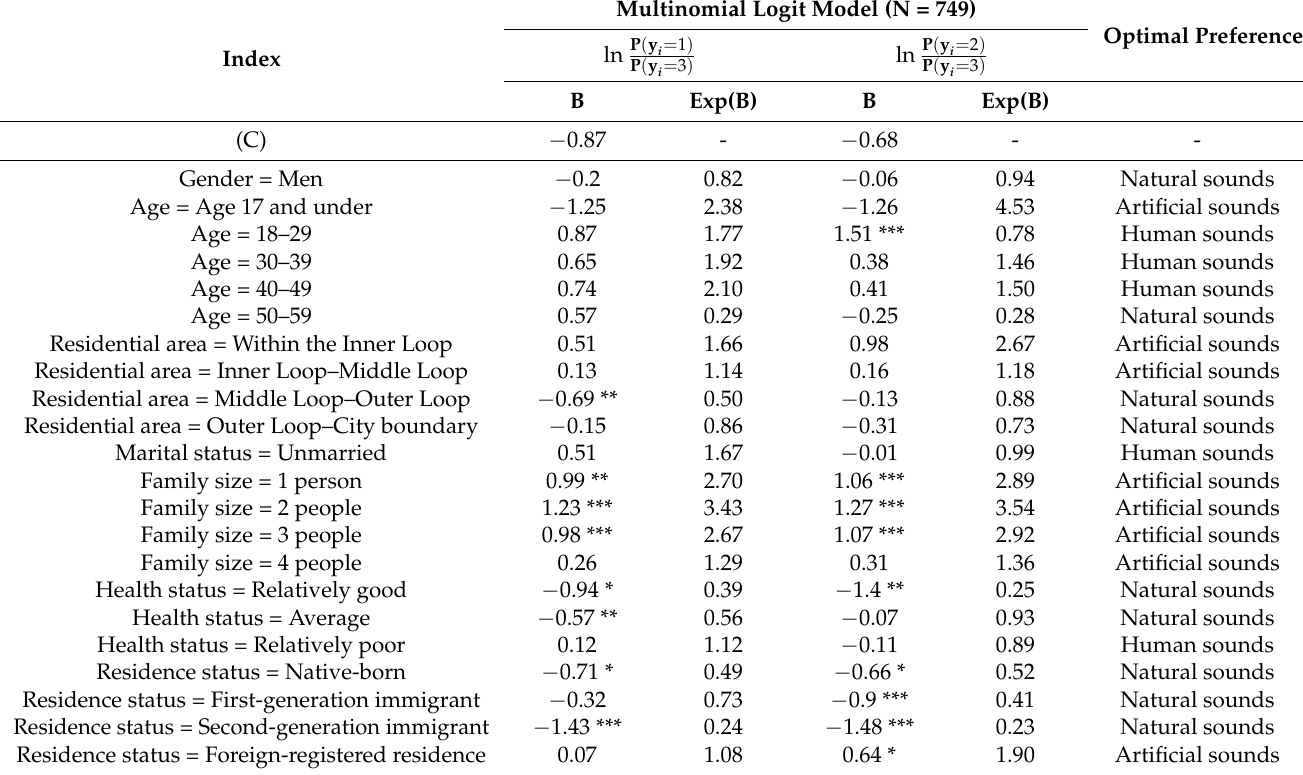
Table 8. Multinomial logit model for the residents’ individual